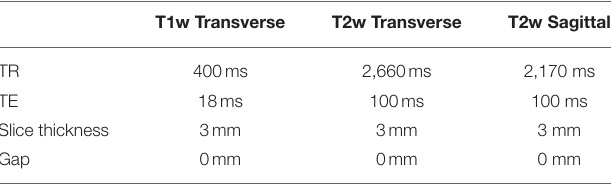
TABLE 1 | MRI acquisition parameters: settings for T1w–T2w transverse and sagittal